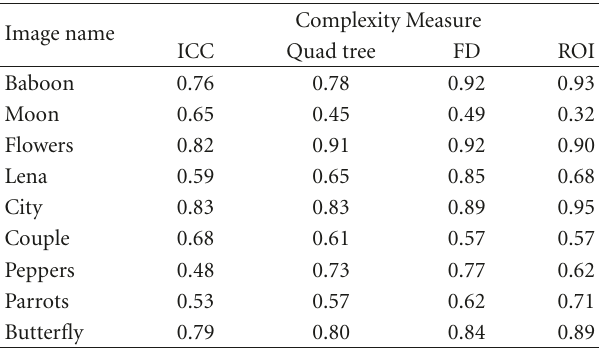
Table 1: Complexity values calculated by ICC, Quad tree, FD (Fractal Dimension) and ROI methods for images in Figure